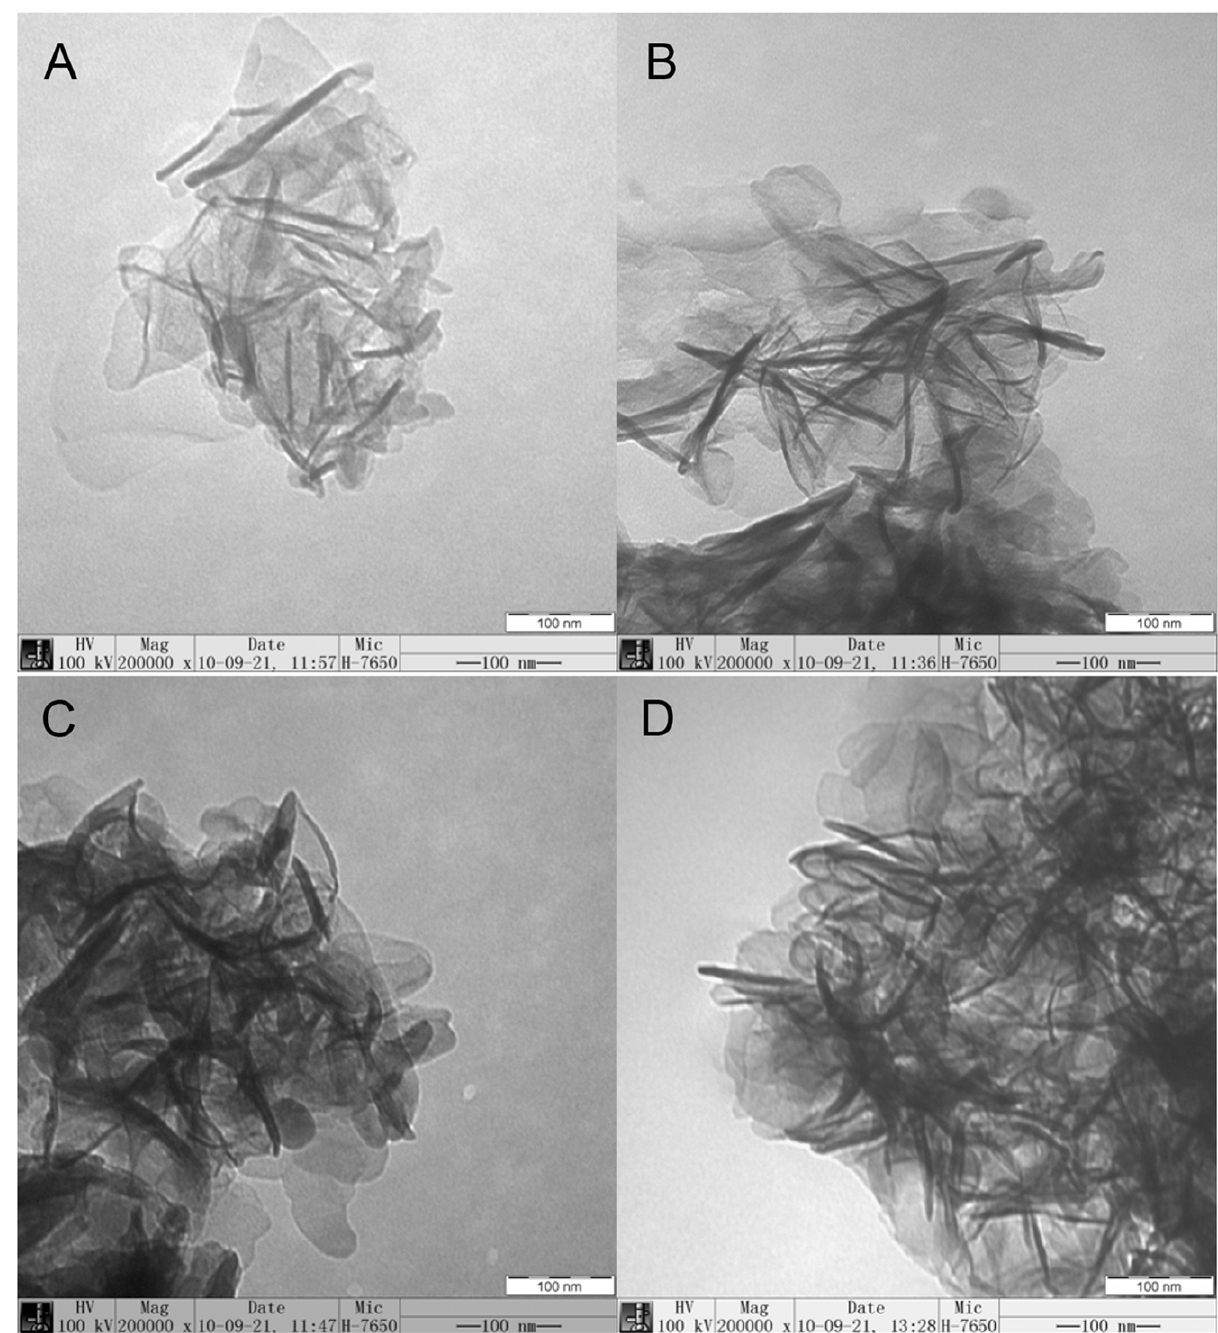
Figure 4. TEM images of the synthesized LDHs. A: S-Ni 0.1 MgAl, B: S-Ni 0.1 MgAl-Nd, C: S-Ni 0.1 MgAl-Ce and D: S-Ni 0.1 MgAl-La.